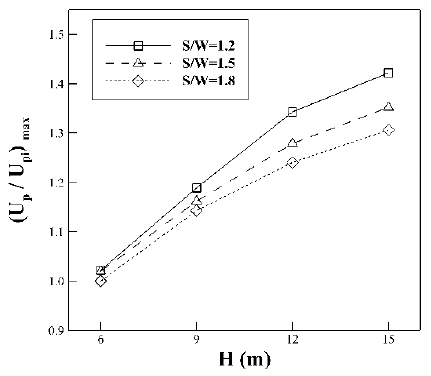
Figure 15. Normalized magnitudes of maximum pedestrian wind speeds.